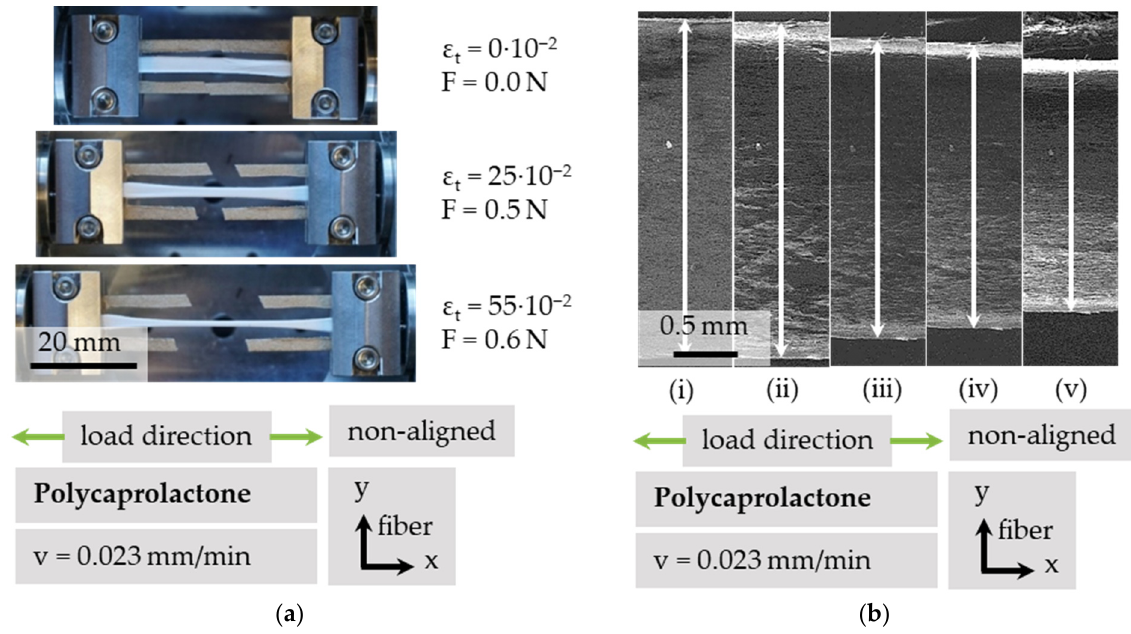
Figure 8. Tensile testing of customized PCL sample in macroscopic view ( a ) and resulting transversal contraction of non-aligned PCL, monitored via SEM ( b ). The corresponding load steps are shown in Table 1. Table 1. Strain and contraction of non-aligned PCL, quantified via SEM and imaging processing software, corresponding to Figure 8b.